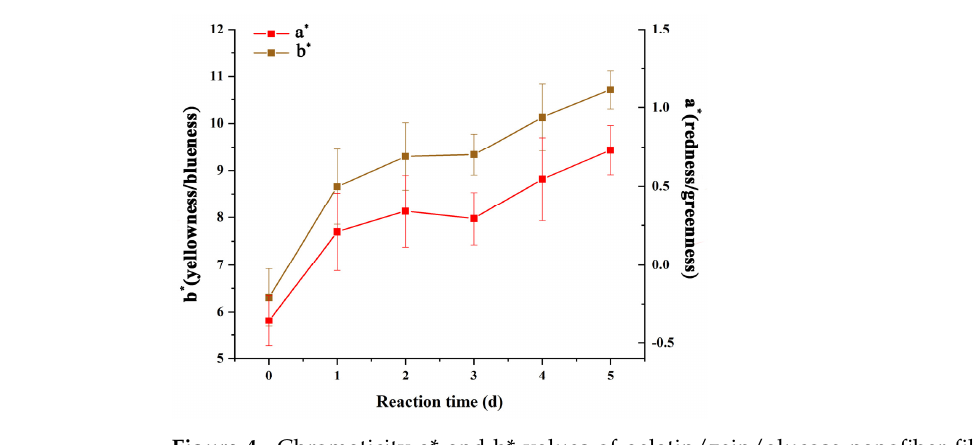
Figure 4. Chromaticity a* and b* values of gelatin/zein/glucose nanofiber films after Maillard reac- tions conducted at 60 °C and 50% RH for 0~5 days.